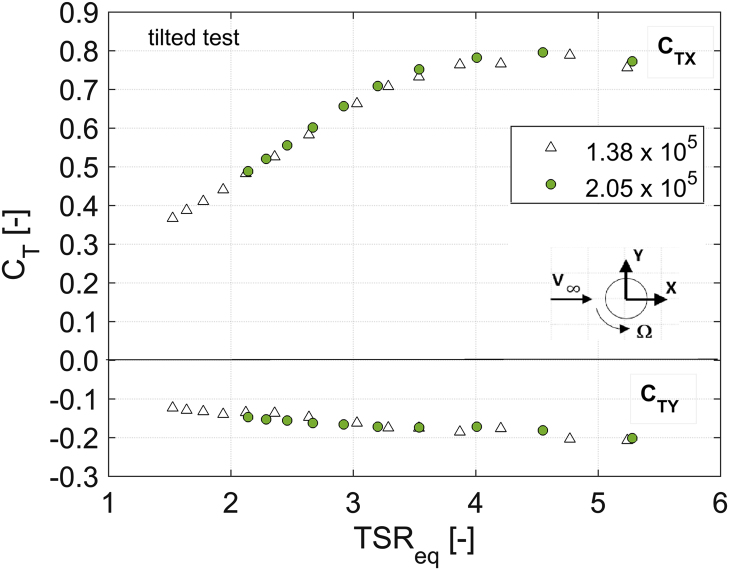
CTX and CTY curves for the tilted rotor at 200 rpm (Re=1.38×105) and 300 rpm (Re=2.05×105).